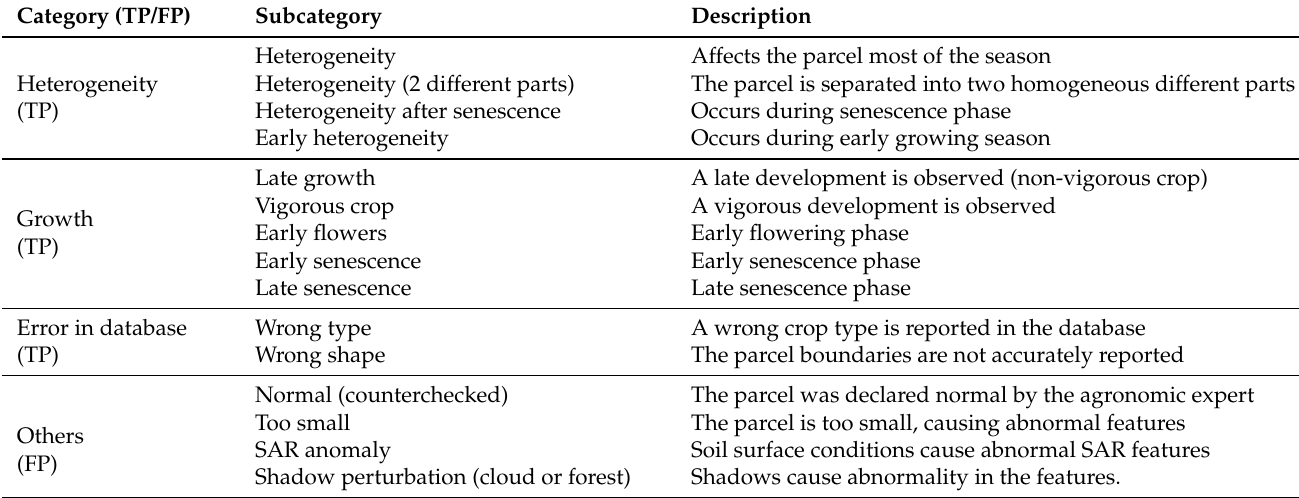
Table 5. Description of the different categories of anomalies detected during the labeling process. Subcategories were added to have a more precise description. For each category TP means true positive, considered relevant for crop monitoring, and FP means false positive, considered irrelevant for crop